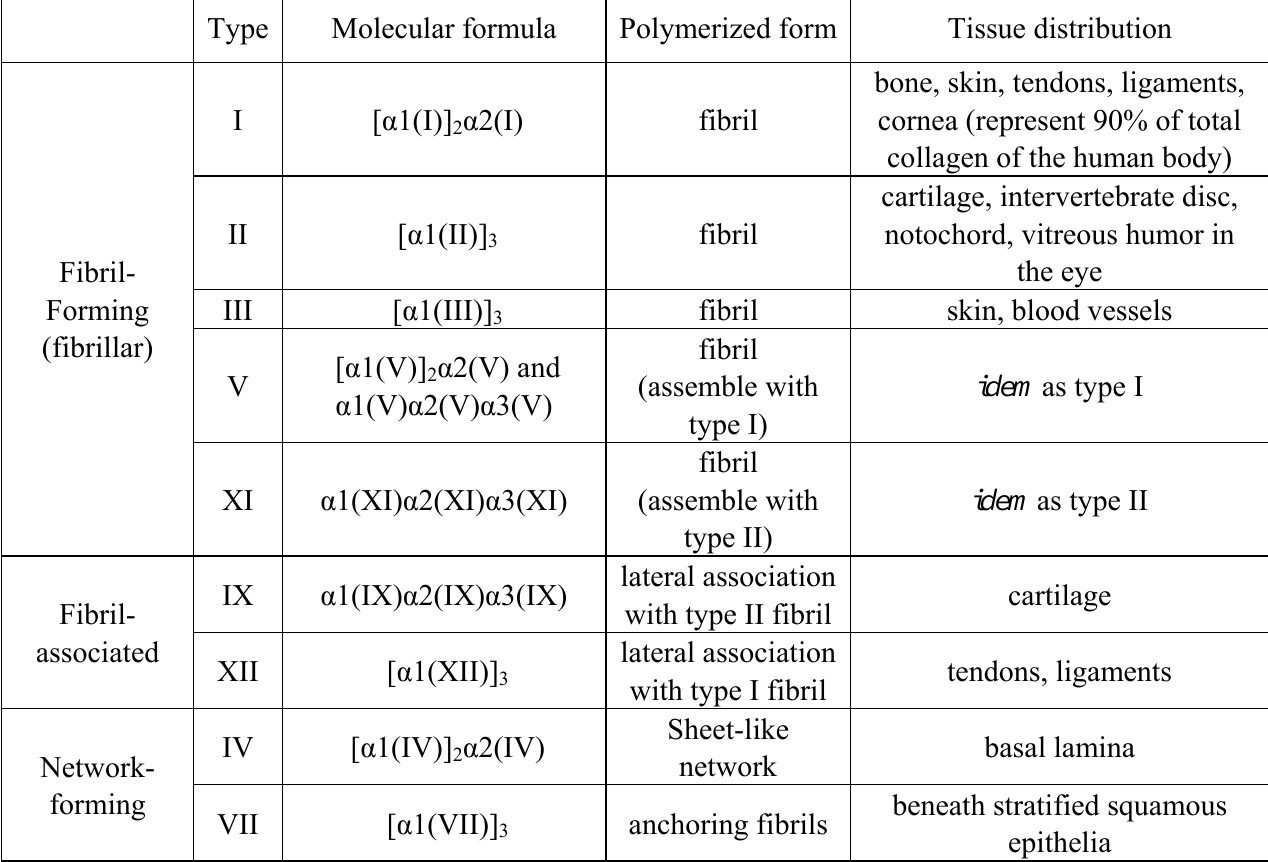
Table 1. Collagen types, forms and distribution. Modified from [1].